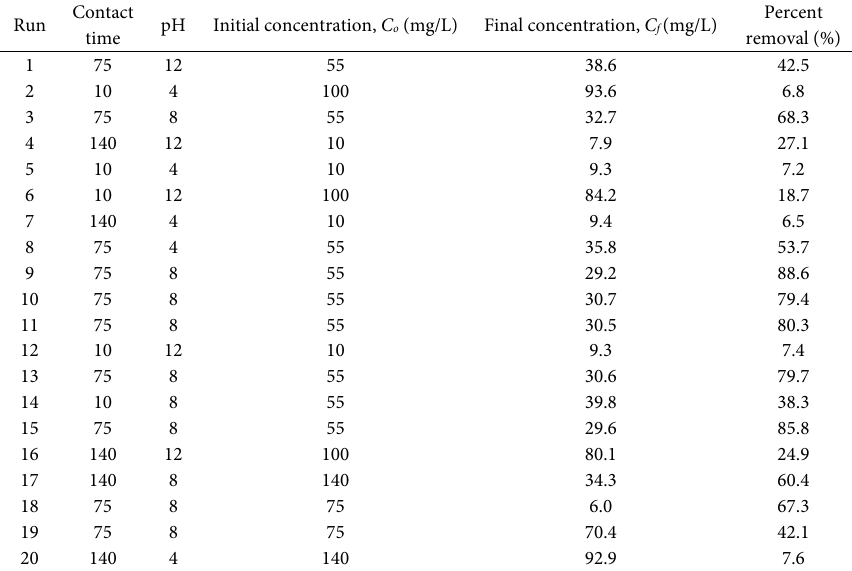
Table 3. Percent removal of arsenic for 20 runs of